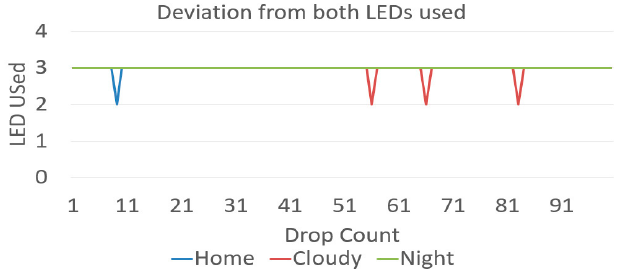
Figure 16. Drop count and LED used in different ambient conditions.